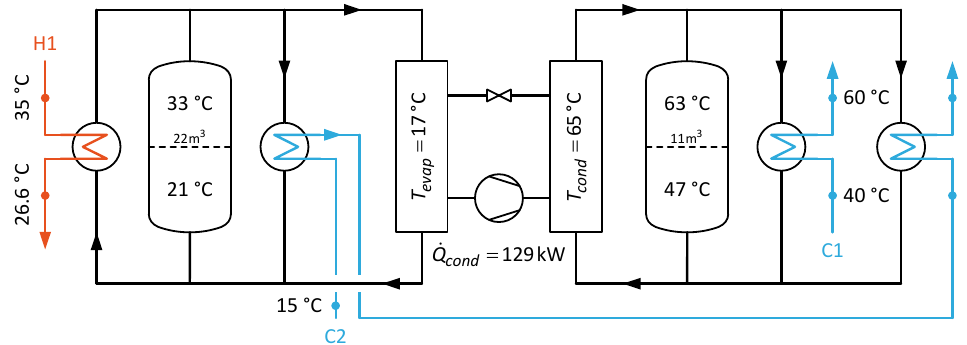
Figure 9. Schematic of Solution Variant 3: Combined IHR and HP system with IHR of 80